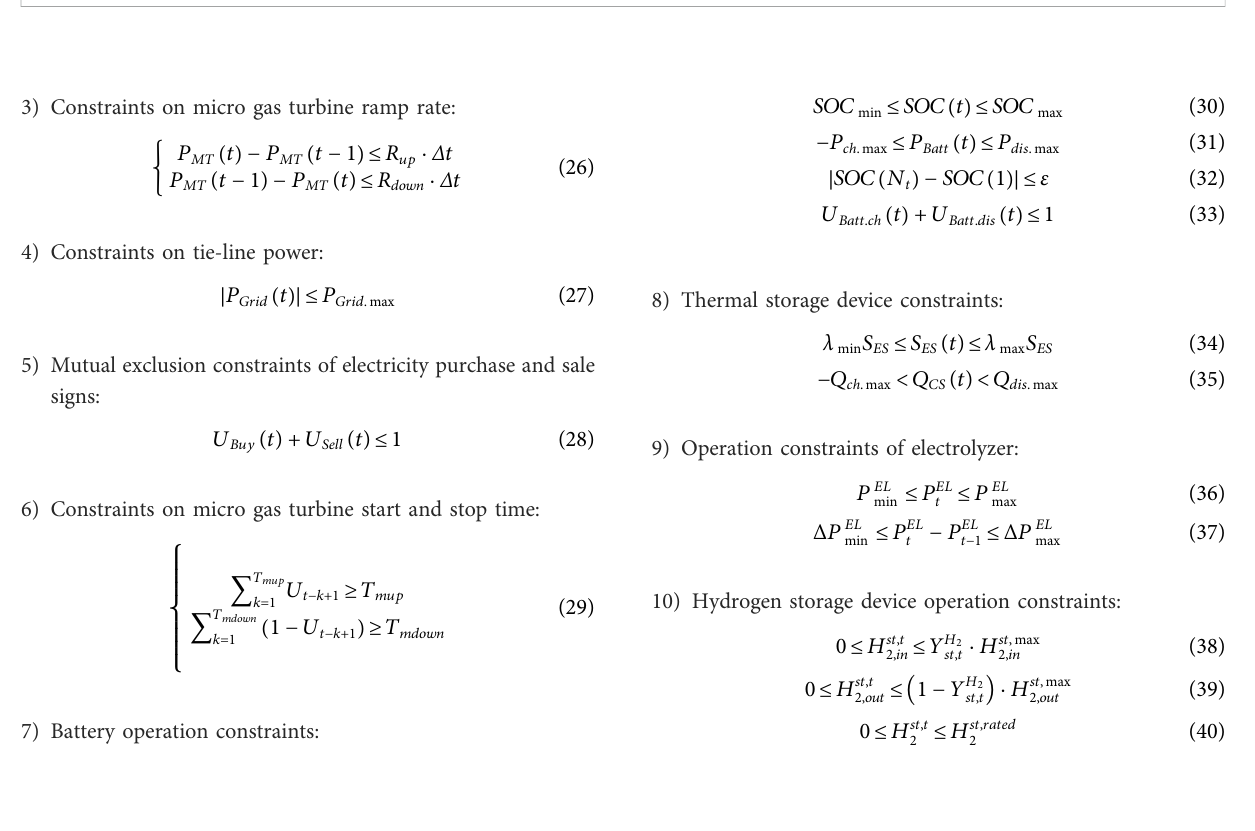
FIGURE 4 Monte Carlo-MISSA algorithm fl ow